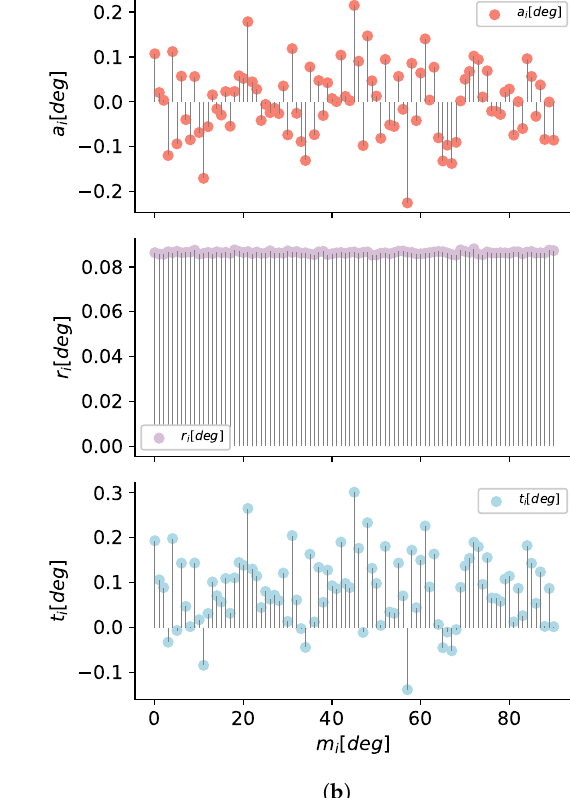
Figure 9. Results of accuracy, repeatability, and total error, for ( a ) x – roll , ( b ) y – pitch , and ( c ) z – yaw , axes of the LSM9DS1.